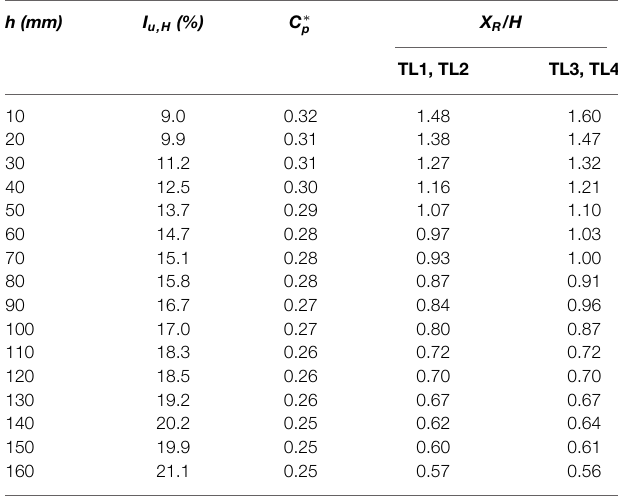
TABLE 3 | Reduced pressure coefficient and mean reattachment length estimates (narrow